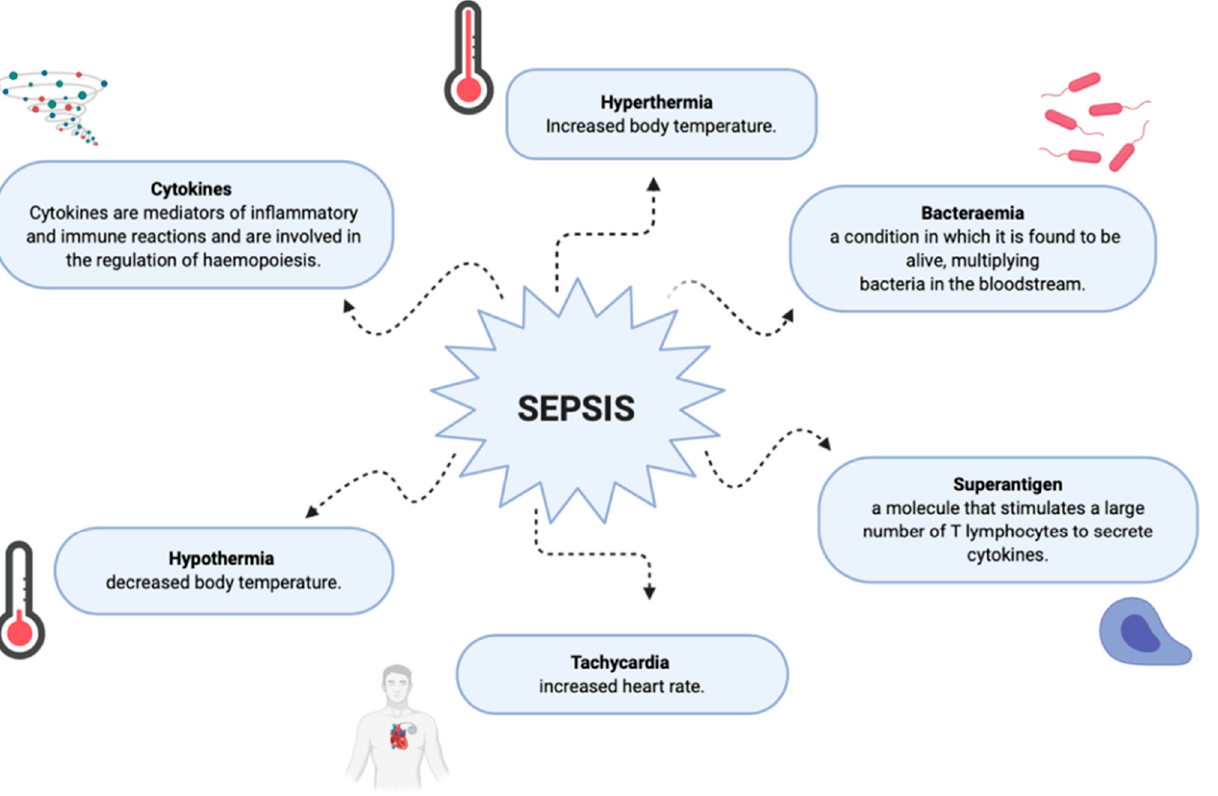
Figure 7. Potential symptoms of sepsis.